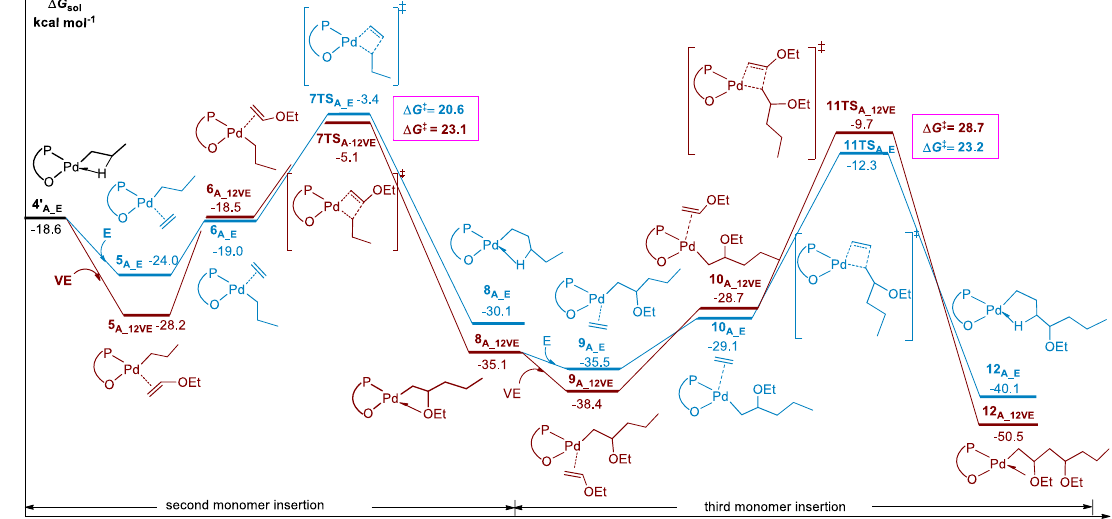
Figure 3. Energy profiles for the second monomer insertion into ethylene pre-inserted intermediate ( 4′ A_E ) and the third monomer insertion into VE and ethylene pre-inserted intermediate ( 8 A_12VE ).